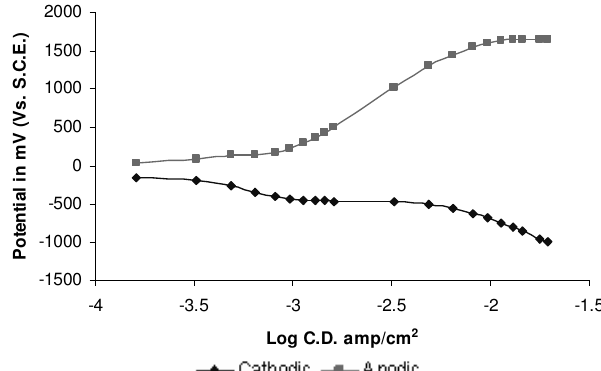
Figure 4 . Effect of varying current density on the cathode and anode potential of tin coated steel in 0.5M monochloroacetic acid in the presence of 1.0% Potassium chromate